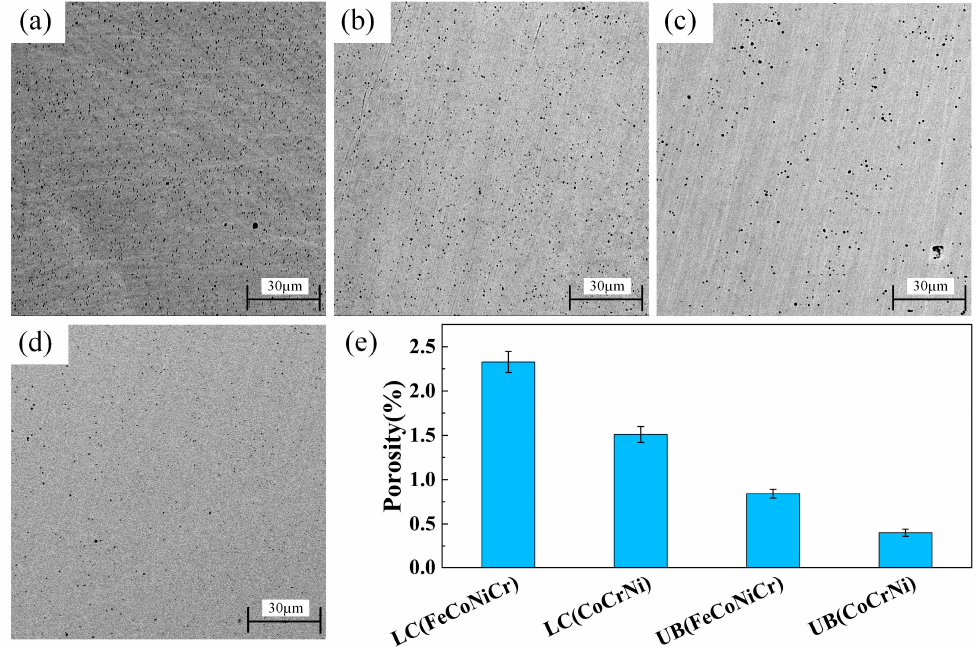
Figure 5. SEM images of coating sample surface morphologies. ( a ) LC(FeCoNiCr), ( b ) LC(CoCrNi), ( c ) UB(FeCoNiCr), ( d ) UB(CoCrNi), and ( e ) the porosities of coating samples.